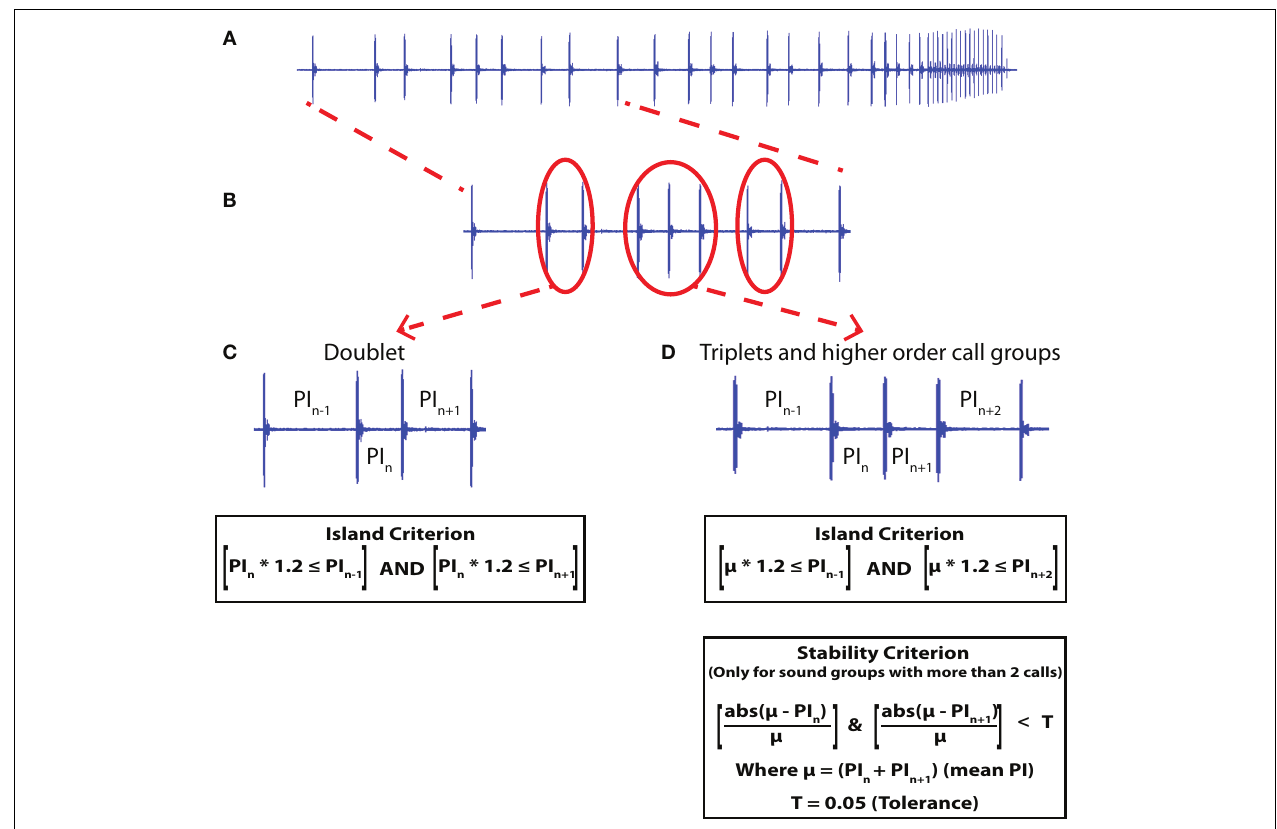
FIGURE 1 | Sonar sound groups. (A) A sonar call sound stream from a bat tracking a tethered meal worm following the Simple Motion (SM) trajectory. (B) DoubletsandTripletsoundgroups. (C) AdoubletisidentifiedbythePIofthe callsateitherendofthedoubletbeingatleast1.2timeslargerthanthePIofthe doublet(IslandCriterion). (D) Higherordersonarsoundgroupsareidentifiedby